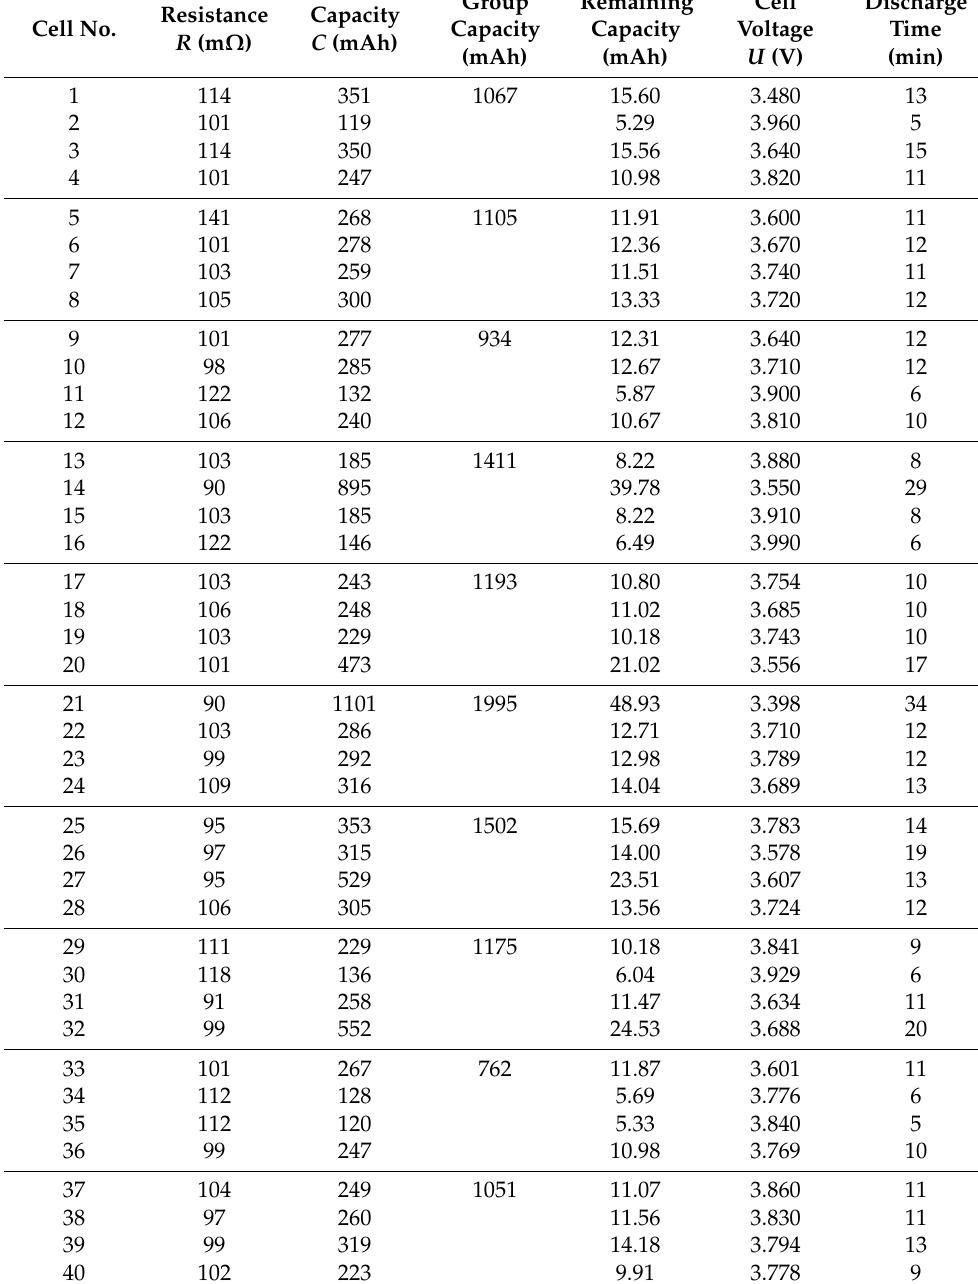
Table 2. Battery pack cell parameter values during 2 A